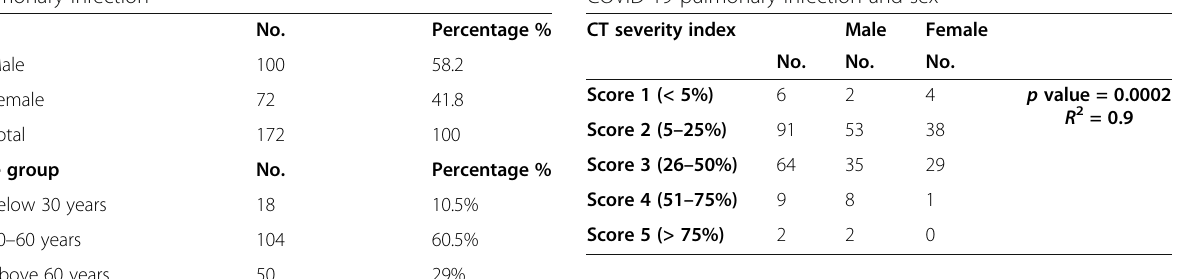
Table 3 Correlation between CT severity index of patients with